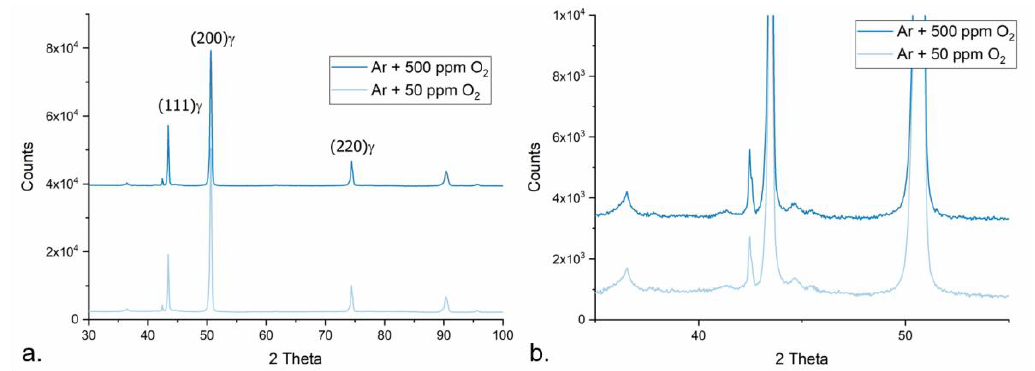
Figure 4. ( a ) XRD pattern of the as-built cubes produced with argon for different residual oxygen level. ( b ) Close-up on the patterns in the 35° to 55° range.